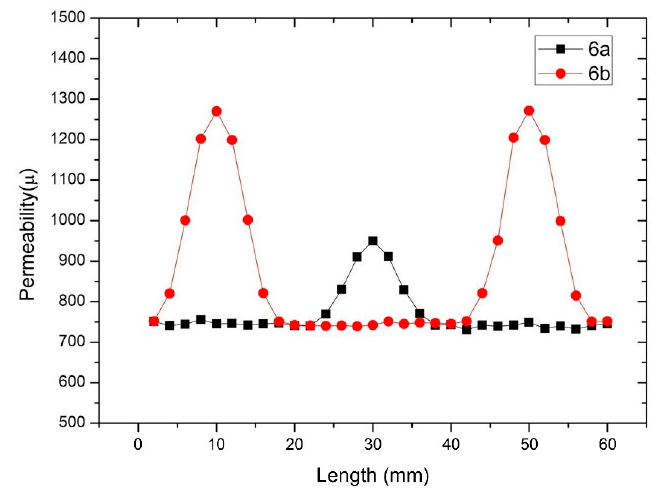
Figure 7. Permeability dependence on the position of measurement for the test coupon of low carbon steel: ( a ) Use of the one-turn coil at d = 0.2 mm and ( b ) use of the V-shape or U-shaped conductor of Figure 5.